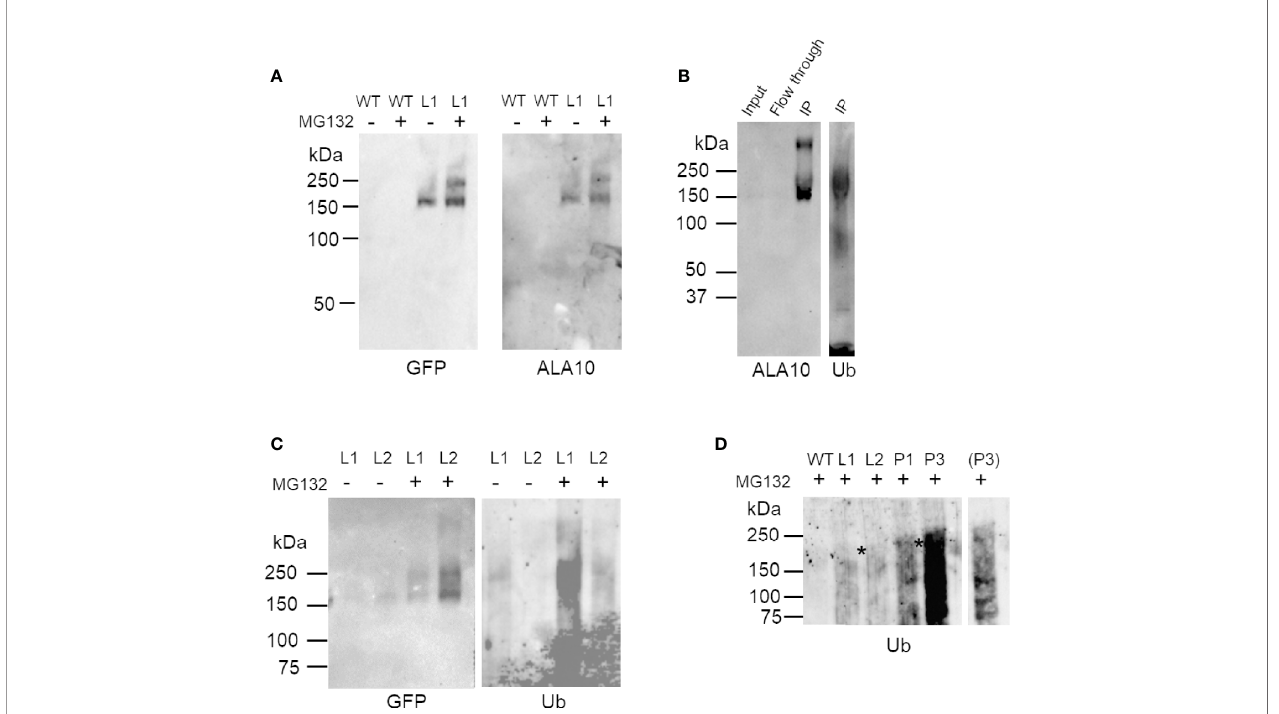
FIGURE 2 | Western blot analysis of ALA10 ubiquitination. (A) Immunopuri fi cation of ALA10-GFP from plants with stable expression of ALA10-GFP (L1). Comparison with WT. Proteins are prepared from membranes extracted from plants treated the day before harvest with 50 µM MG132, 0.1% DMSO (+) or with only DMSO ( − ). They are solubilized with 1% Triton X100 and loaded on µMACS microbeads conjugated to an anti-GFP monoclonal antibody (Miltenyi). Puri fi ed fraction is analyzed by western blot with antibodies against ALA10 or GFP. (B) - ALA10-GFP fusion protein stably expressed in L2 plants was immunopuri fi ed (IP) on µMACS microbeads conjugated to an anti-GFP monoclonal antibody (Miltenyi) and analyzed by Western blot with anti-ALA10 and anti-ubiquitin antibodies. Plants were treated the day before harvest with 50 µM MG132 in 0.1% DMSO. (C) Immunopuri fi cation of ALA10-GFP from plants pretreated or not with MG132, an inhibitor of the proteasome. Samples are two lines of plants with different level of expression of ALA10-GFP, L1 and L2. Plants were treated the day before harvest with 50 µM MG132, 0.1% DMSO (+) or with only DMSO for control ( − ). Samples are analyzed with anti-GFP and anti-ubiquitin antibodies. (D) Comparison of ALA10 ubiquitination in pub11 relative to WT. ALA10-GFP was immunopuri fi ed in two lines of pub11 with stable expression of ALA10-GFP, P1 and P3, and compared to WT, L1 and L2. Plants were treated the day before harvest with 50 µM MG132, 0.1% DMSO. A shorter exposure of P3 lane is shown on the side. Stars indicate position of the highest ubiquitin signals that were detected in the L or P